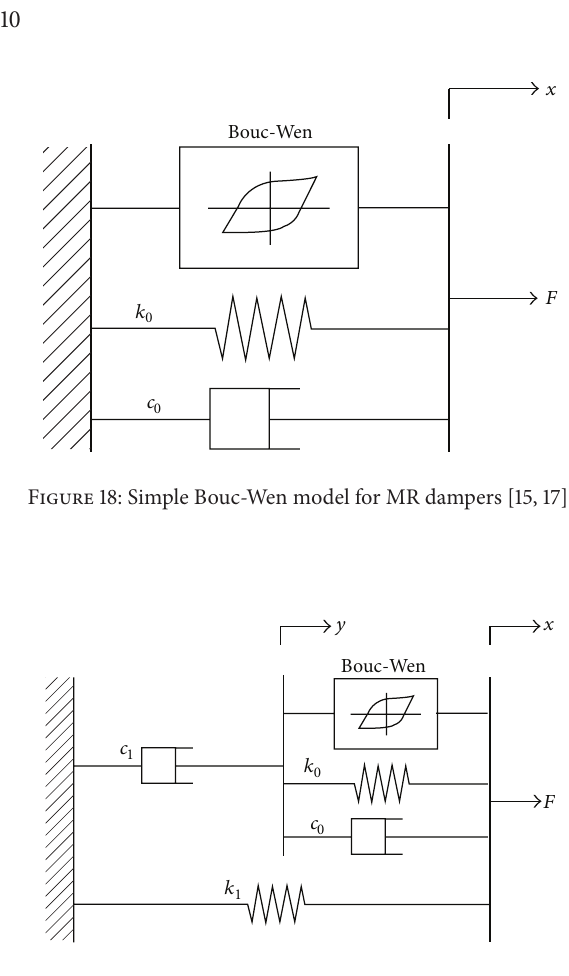
Figure 19: Modified Bouc-Wen model for MR dampers [15,